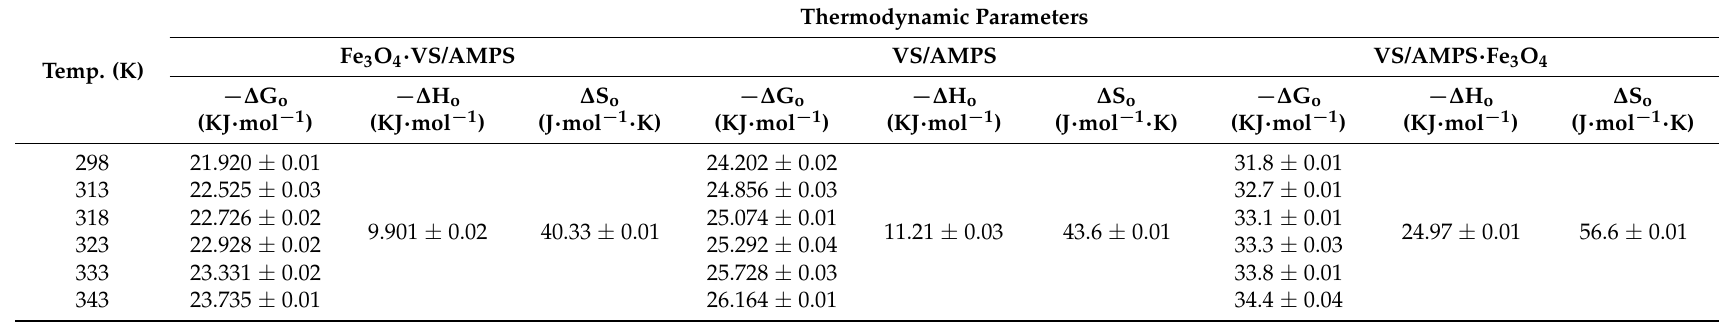
Table 2. Adsorption thermodynamic of MB aqueous solutions using VS/AMPS cryogel and its composites at different temperatures.